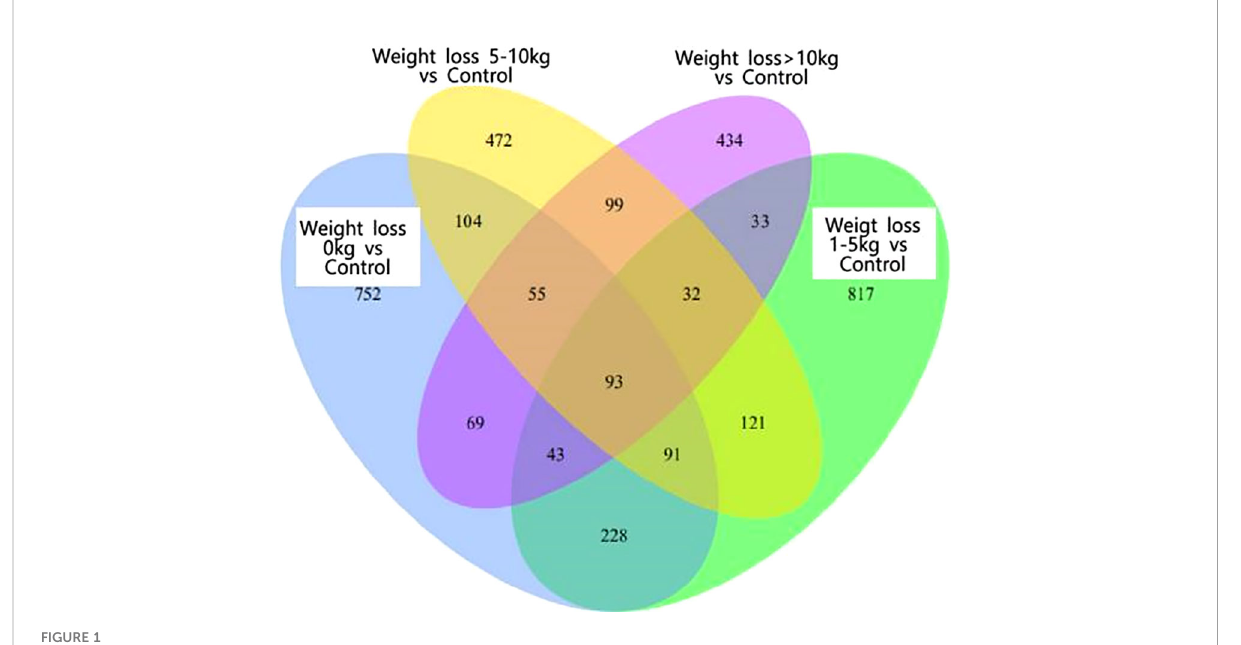
FIGURE 1 Venn1and.